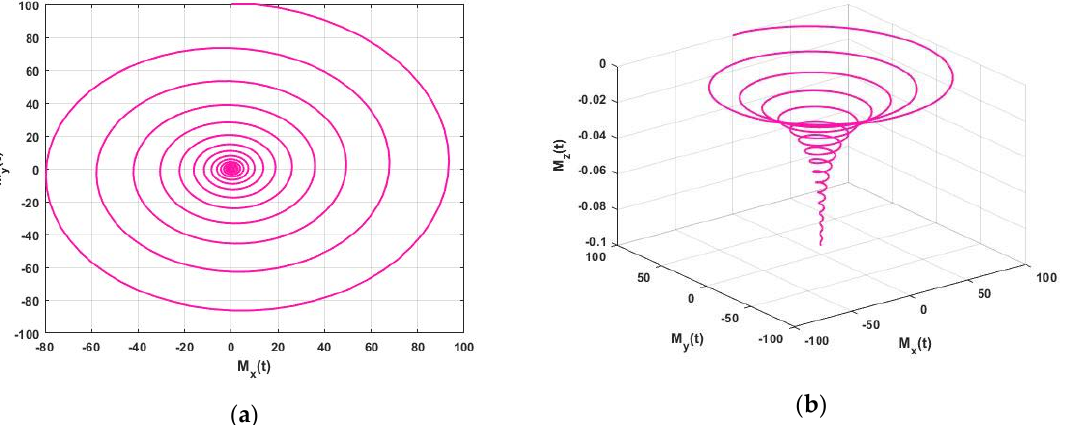
Figure 5. Approximate solution ( a ) 2D Plot and ( b ) 3D Plot of the FNMRF system for α = β = η =